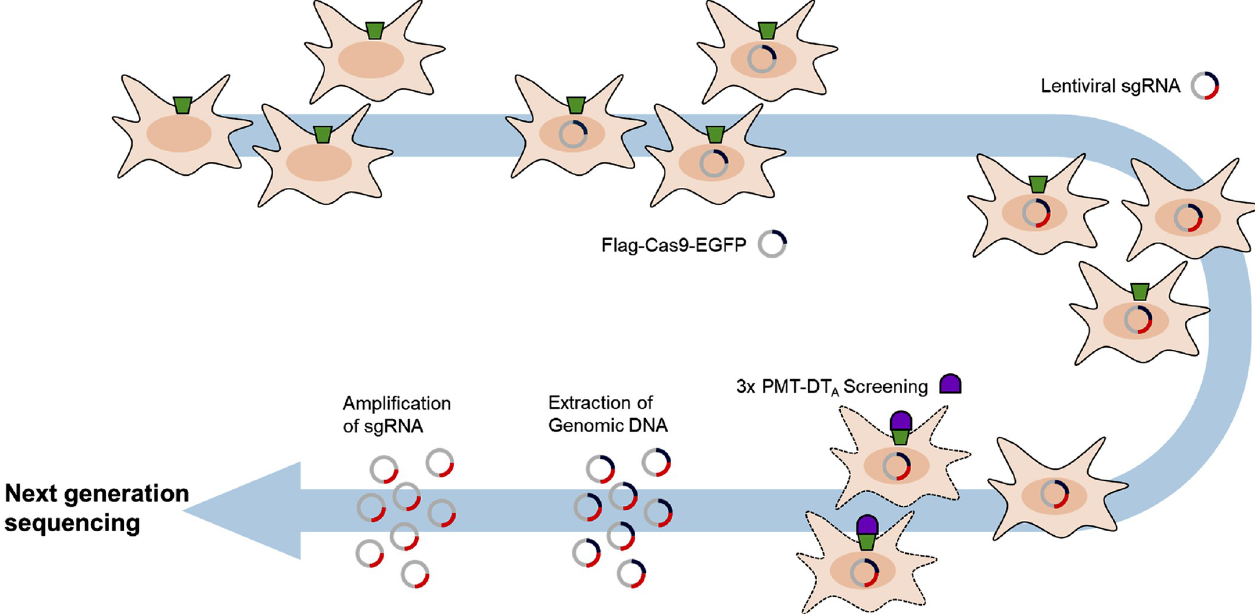
Fig 1. Schematic presentation of the CRISPR/Cas9-Knock out screen. Mouse embryonic fibroblasts (MEF) stably expressing Flag-Cas9-EGFP were transduced with a lentiviral CRISPR-library. Cells were treated three times with PMT(C1165S)DTa and surviving cells grown. Genomic DNA was extracted, inserted sgRNA amplified and